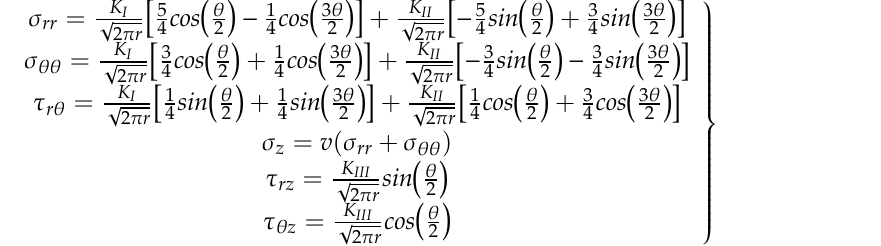
Figure 14. Infinitesimal kink at the tip in different coordinates. ( a ) The crack ‐ tip stress fields in polar; ( b ) The local stress fields in x (cid:48) − y (cid:48) coordinates. Stress fields ahead of the crack front for Mode I, Mode II and Mode III at an angle θ in polar coordinates are shown in Formula (6).